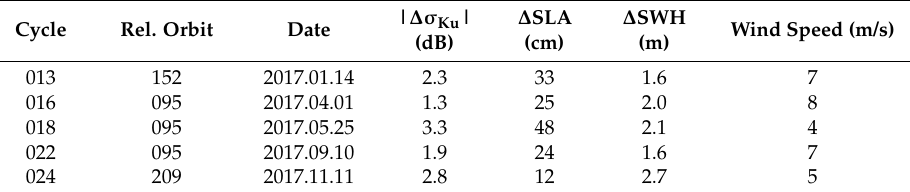
Table 1. A summary of selected synthetic aperture radar altimeter (SRAL) observations of internal solitary waves (ISWs) off the Amazon shelf confirmed in Ocean Land Colour Imager (OLCI) images, with corresponding geophysical parameter variations and wind velocities at the time of acquisition. ∆ σ Ku refers to peak-to-trough variations of sigma0 for a single event; SLA is peak-to-trough variation of the sea level anomaly signal for a single event; SWH is peak-to-trough variation of the significant wave height signal for a single event.